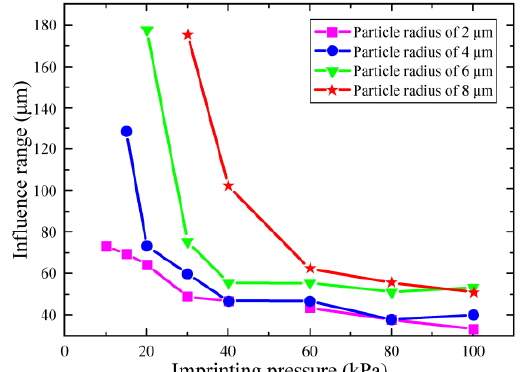
Figure 5. The influence range of fabricated patterns for various pressures on the particles radius from 2 to 8 μm.